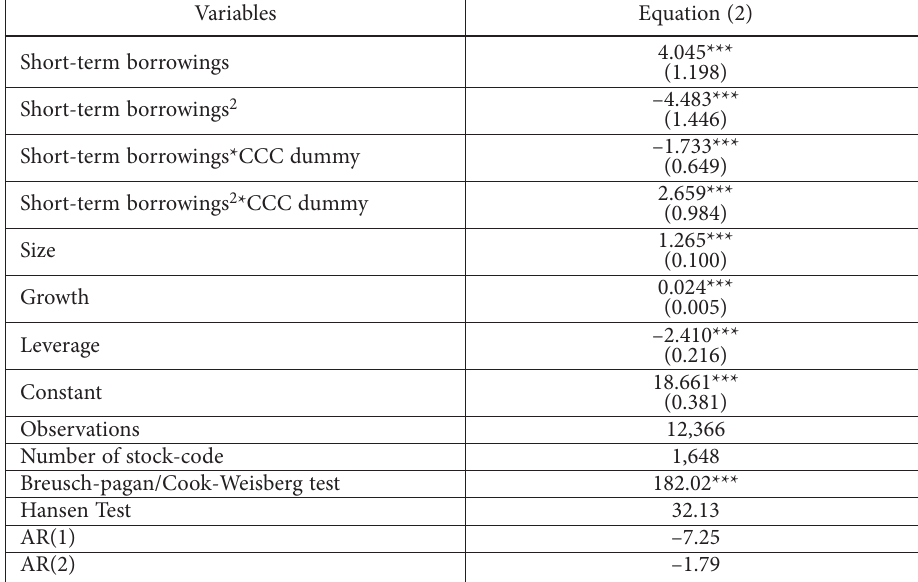
Table 4. Short-term borrowings and Profitability for firms having reduced and extended CCC period